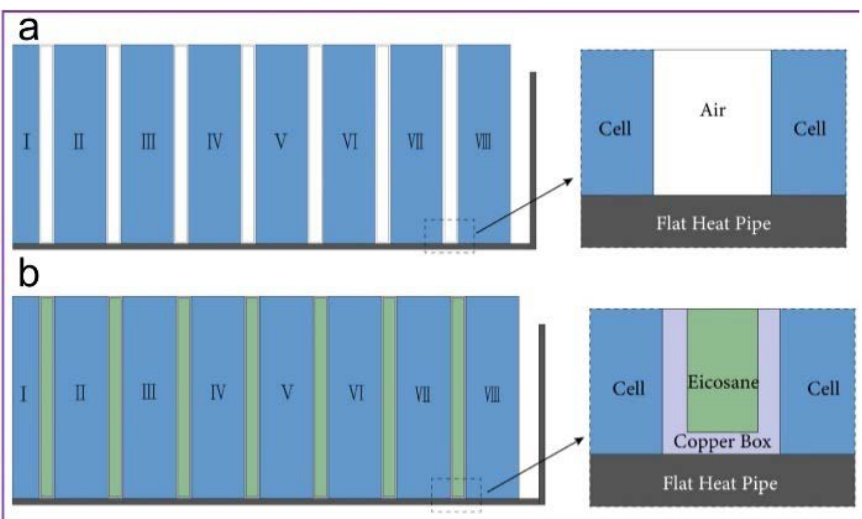
Figure 24. The physical system described in [85] consisting of eight rectangular cells (numbered from I to VIII, aligned with alternating gaps). ( a ) HP BTMS; ( b ) HP-PCM BTMS. Reproduced with permission from Elsevier. discharge rate